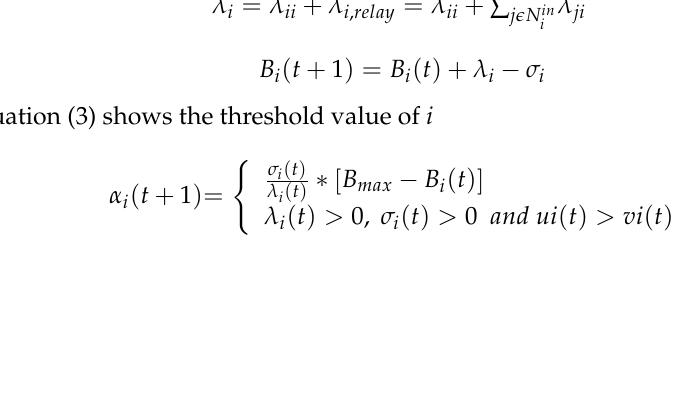
Table 1. Description of parameters.